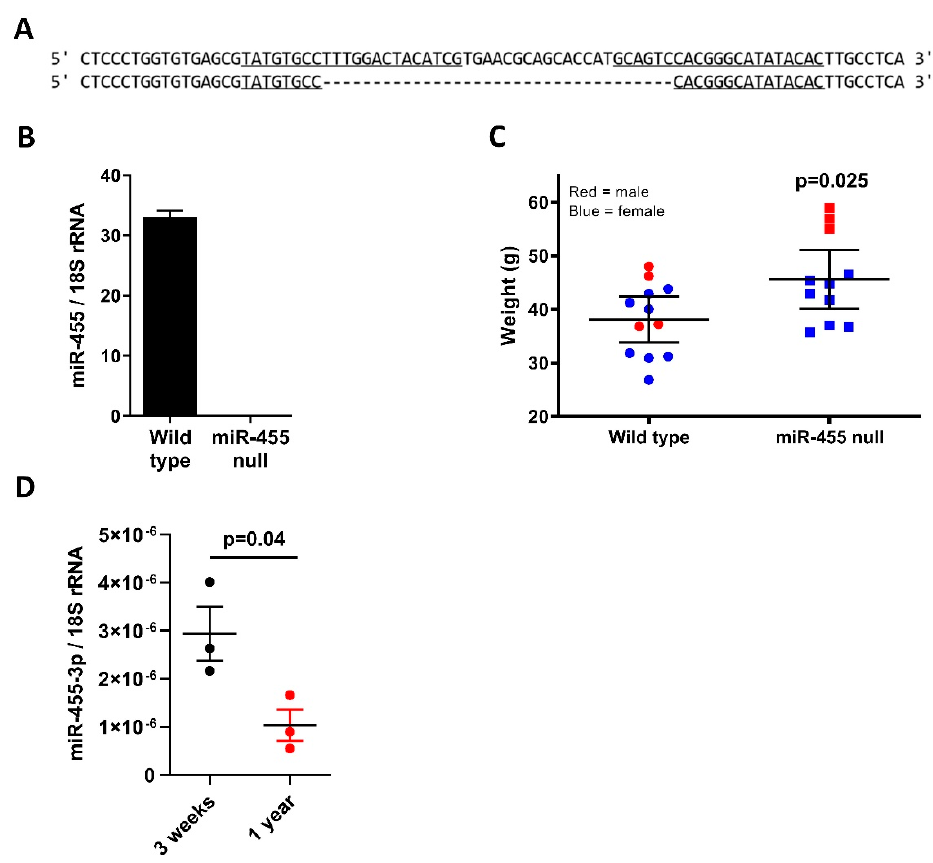
Figure 1. The miR-455 null mouse and the expression of miR-455-3p across age. ( A ) Deletion of miR-455 in mice. Sequencing of miR-455 null founder mouse shows a 35-base deletion, deleting both miR-455-5p and miR-455-3p mature sequences, as well as the intervening hairpin sequence. ( B ) Expression of miR-455-3p in 3-month-old mouse brain tissue. RNA was extracted from brain tissue and qRT-PCR performed; the miR-455 null mouse shows complete loss of miR-455-3p expression. ( C ) MiR-455 null mice show increased weight gain with age. Mice were weighed each month and showed that at 14 months of age, miR-455 null mice ( n = 13) were significantly heavier than wild-type litter mates ( n = 11). ( D ) MiR-455 expression decreases with age in wild-type mice. RNA was extracted from brain tissue at 3 weeks and 12 months of age and qRT-PCR performed ( n = 3). Mean ± SEM.